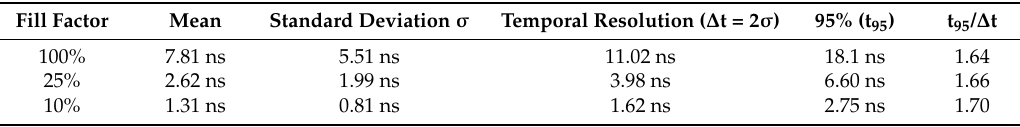
Table 2. Parameters on the electron arrival time